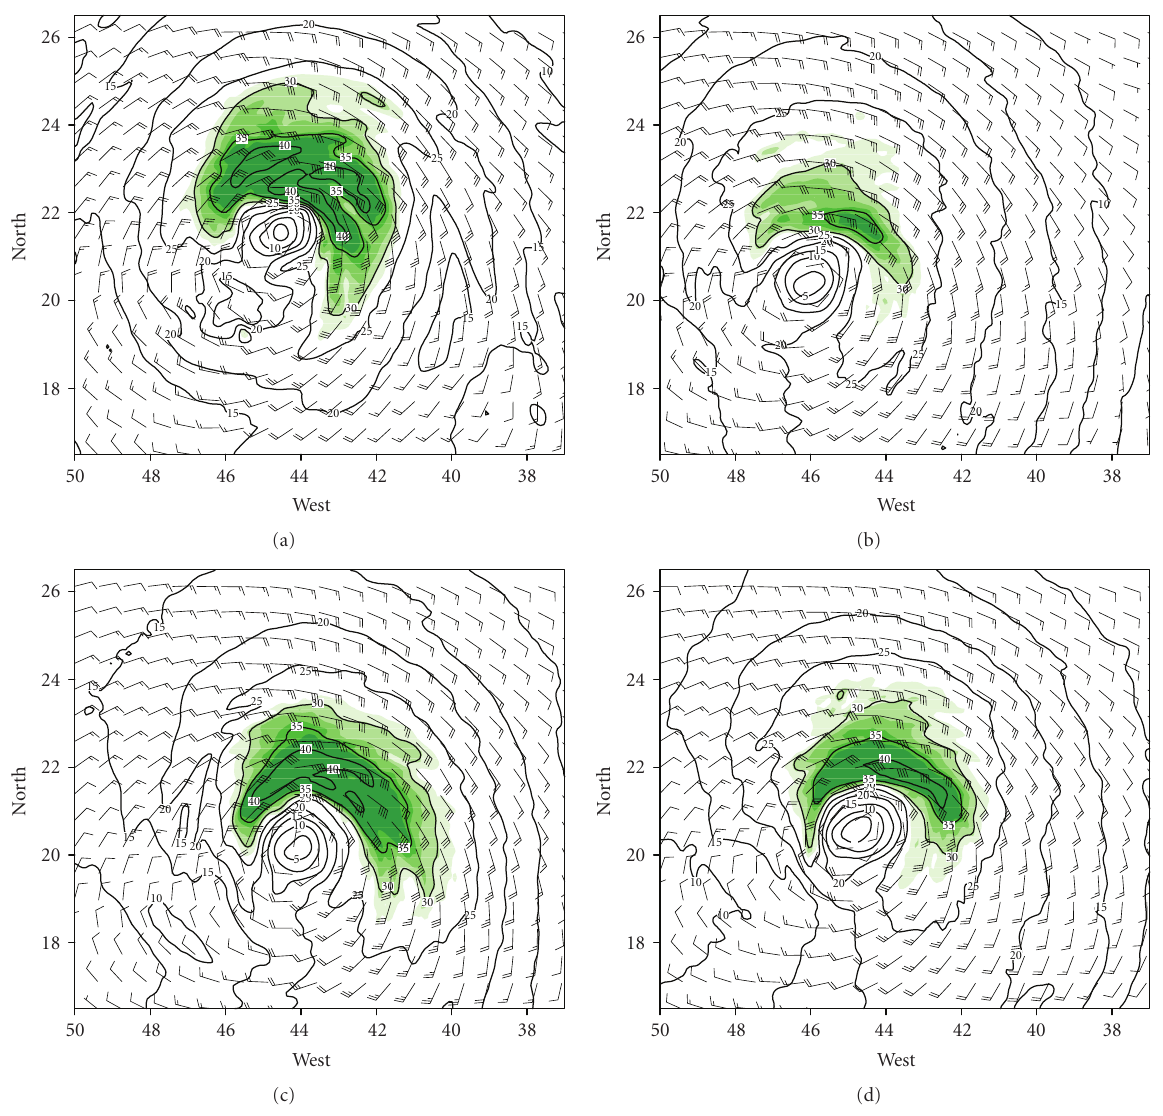
Figure 8: Same as Figure 3 but at 1800 UTC 02 October 2005. The contour interval of wind speed is 5 ms − 1 , the areas with wind speed exceeding 26 ms − 1 are